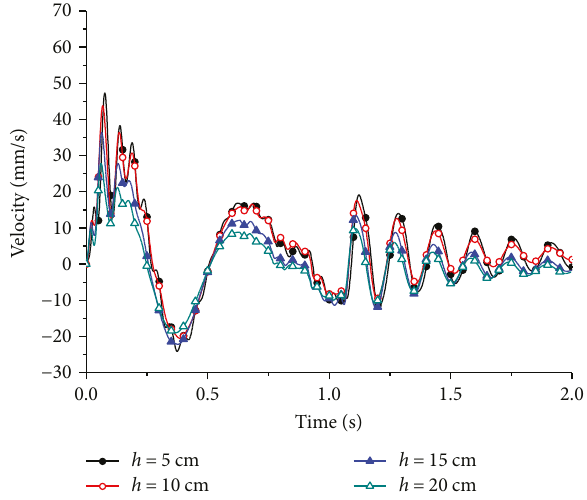
Figure 18: Vertical velocity of launch canister top in di ff erent surface layer